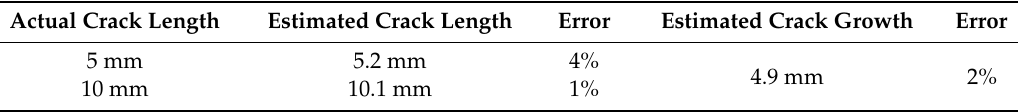
Table 1. The crack and crack growth quantification